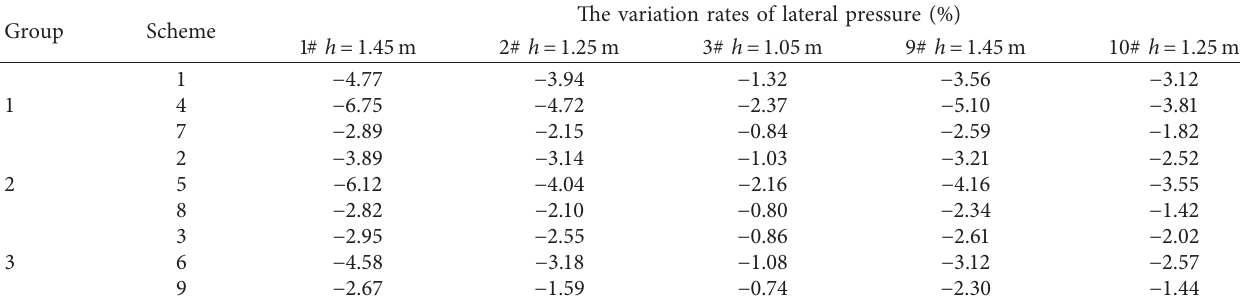
Table 7: The reduction rates of lateral pressure in the first stage for drawing